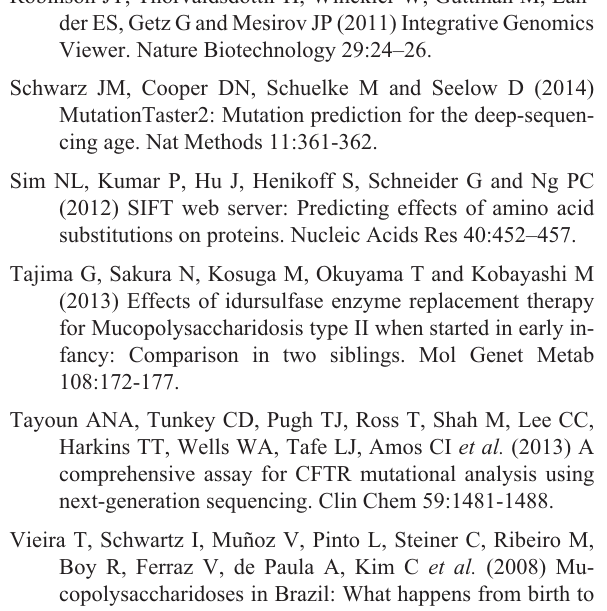
Figure S1 - Relative Depth of Coverage, Panel A. Figure S2 - Relative Depth of Coverage, Panel